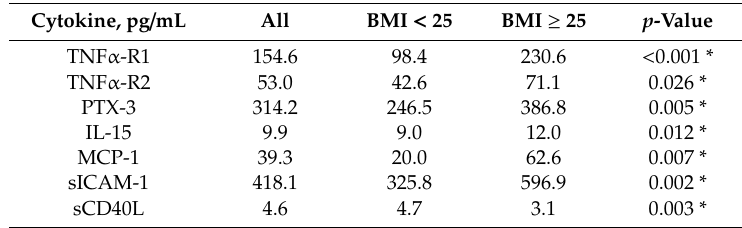
Table 3. Medians of assessed salivary concentrations of inflammatory